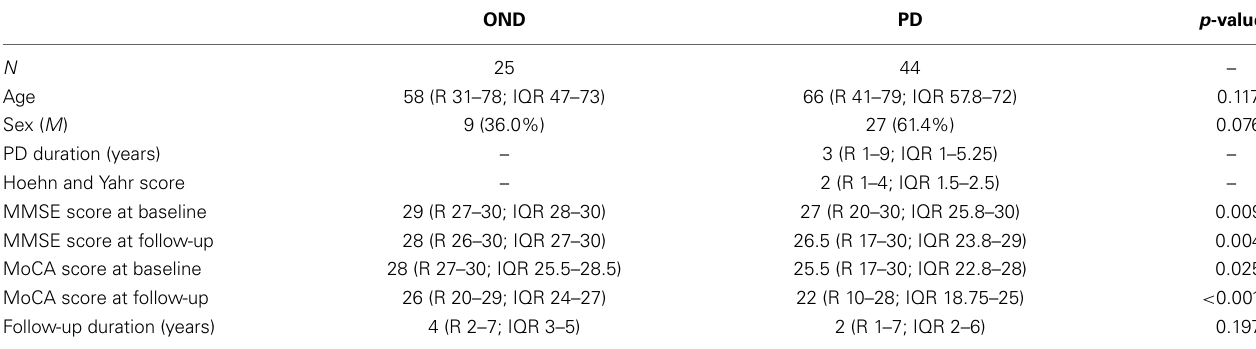
Table 1 | Demographic data and clinical features for OND and PD.